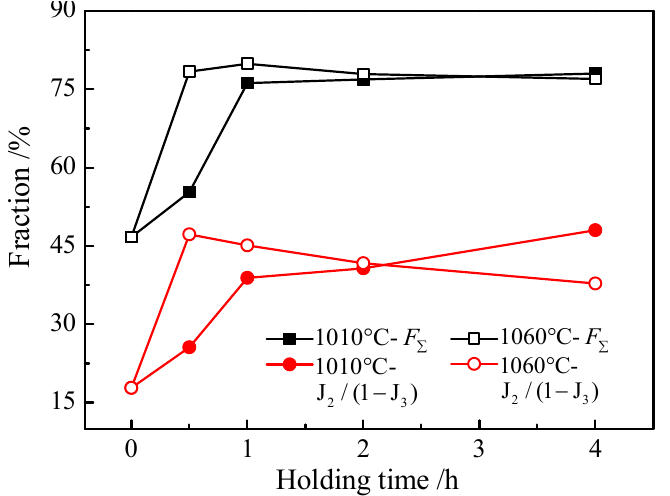
Figure 5. Evolution of the F Σ and J 2 /(1 − J 3 ) with holding time at different solution annealing temper- ature.